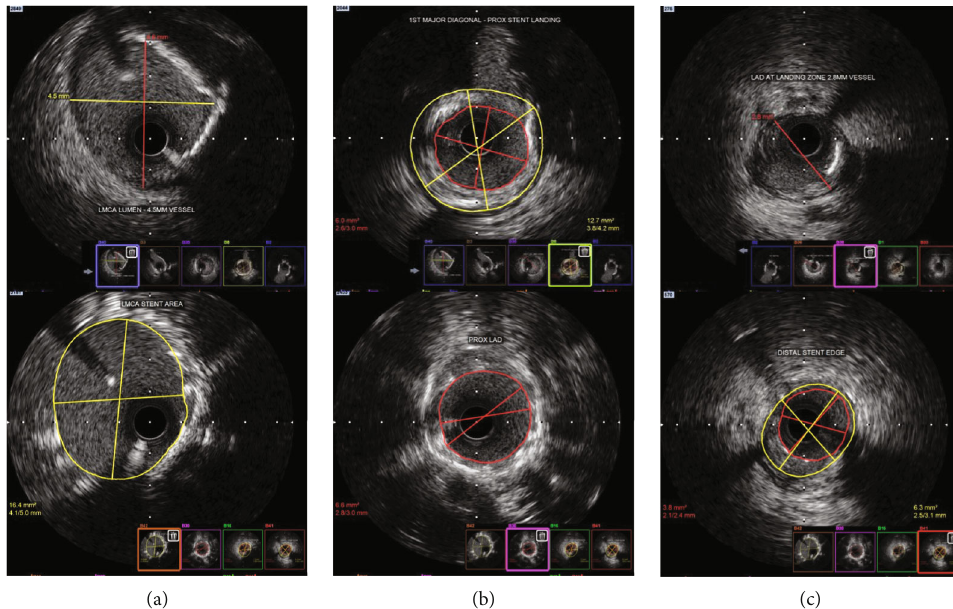
Figure 2: (a) Pre-poststenting images of LMCA. (b) Proximal LAD pre-poststenting. (c) Distal landing zone and stent